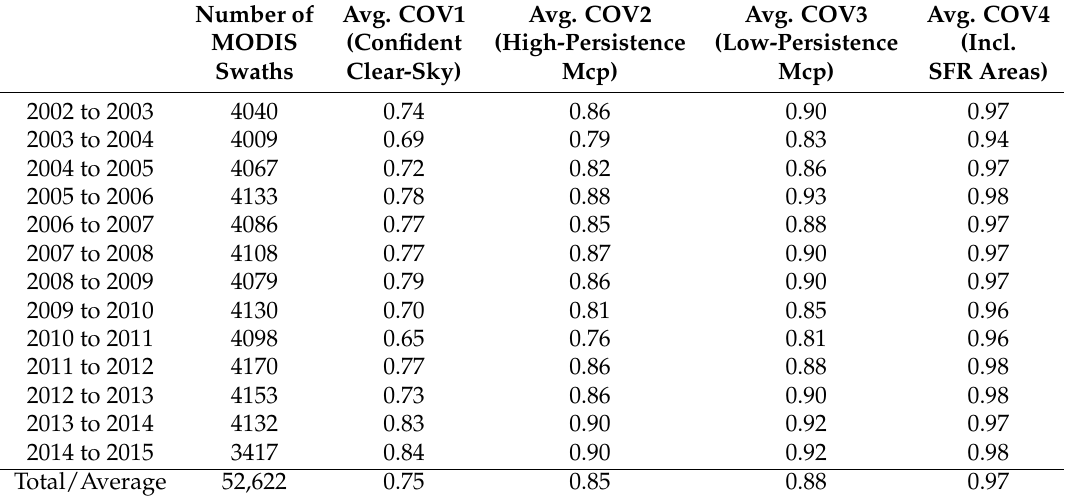
Table 2. MODIS coverage statistics for the period from 2002/2003 to 2014/2015. The second column shows the amount of incorporated MODIS swaths for each winter season (November to March), as well as the total amount for all years combined. COV1 represents the average daily coverage (decimal cover fraction ranging from 0 to 1) of confident clear-sky pixels, while high- (>0.5) and low- (<0.5; min. 1 IST value per day) persistence mcp (mixed-cover pixels) indicate cases where either MODIS or ERA-Interim medium cloud cover features cloud signals in the daily composites. COV4 shows the achieved coverage after application of the spatial feature reconstruction (SFR) approach (compare Section 2.6). All numbers are retrieved based on daily composites and are calculated within the predefined polynya mask. Number of Avg. COV1 Avg.